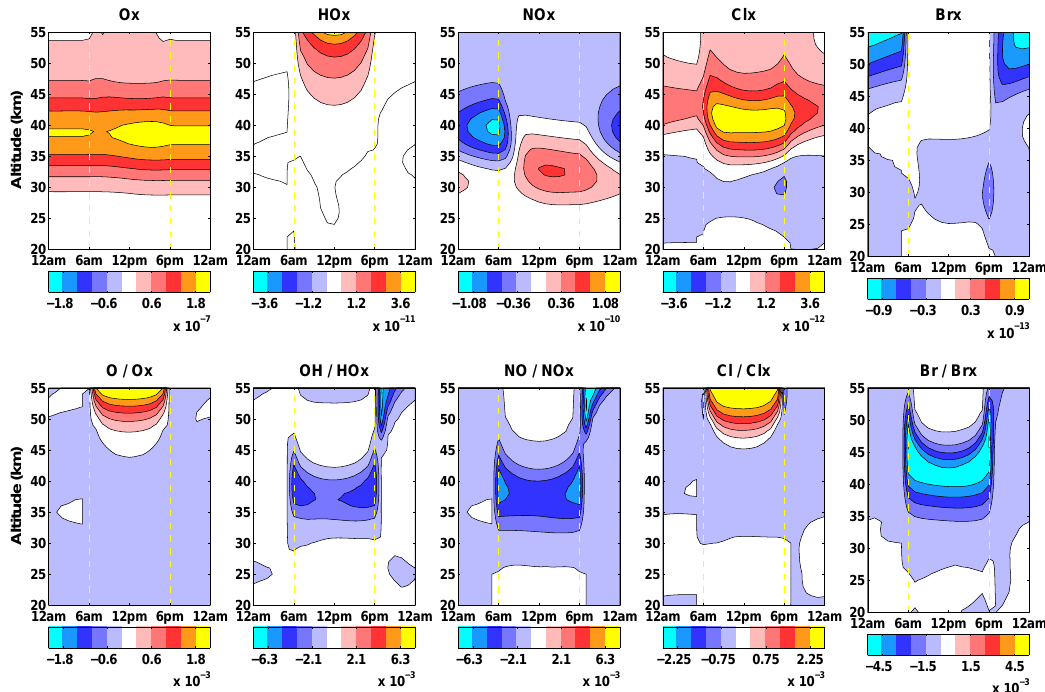
Fig. 3. Diurnal cycle of the chemical differences between the constant solar maximum and minimum simulations on day 5 for the relevant chemical families and their partitioning ratios. Differences in chemical families are shown in units of volume mixing ratio, and in arbitrary units for partitioning ratios. Vertical yellow dashed lines show the sunrise and sunset times, 06:00a.m. and 06:00p.m.,